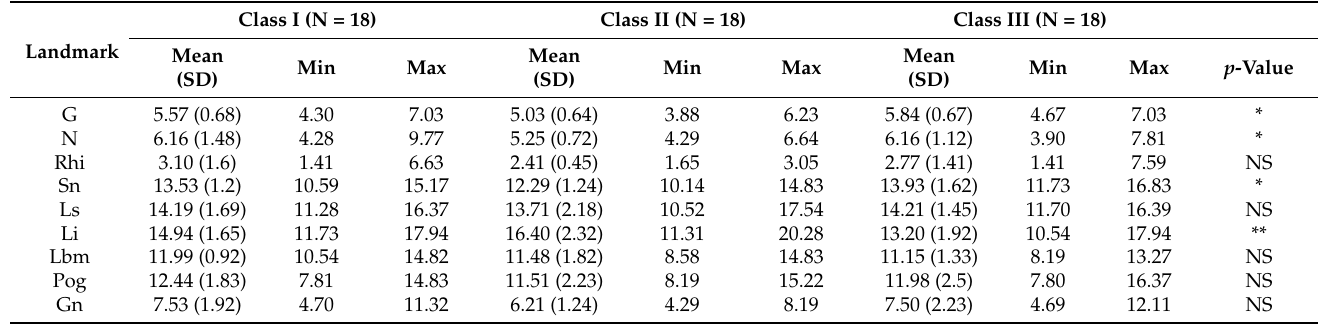
Table 2. The differences between three skeletal classes in FSTT in Korean females.